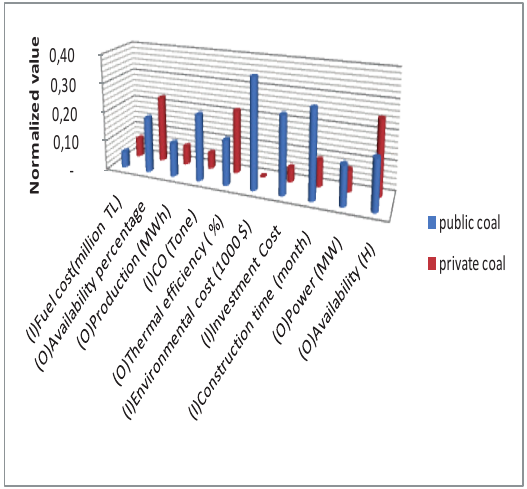
Fig. 2. Comparison of coal - based public and private power plants